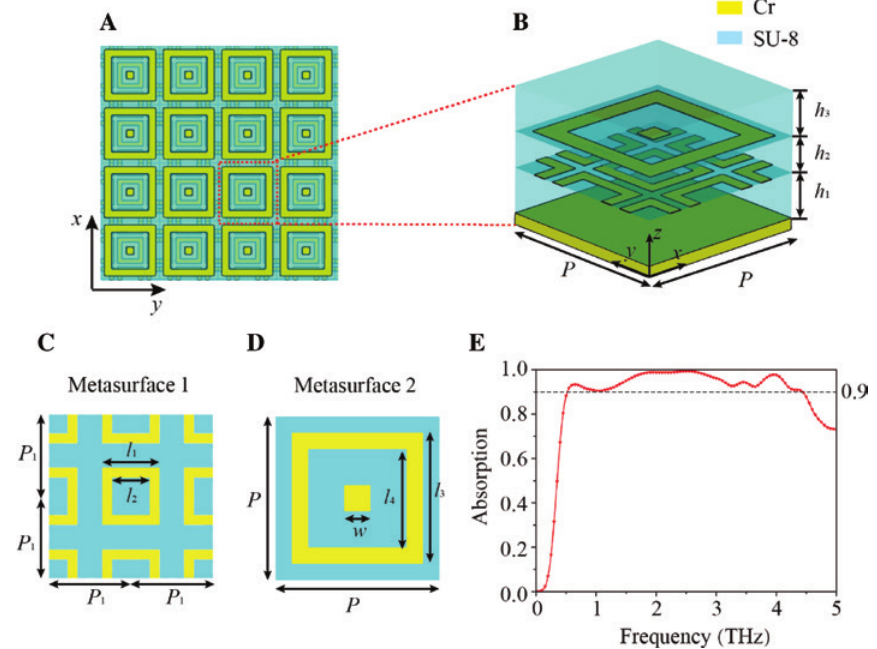
Figure 1: Schematic structure of the broadband THz absorber and simulated results. (A) Top view of the arrays. (B) Three-dimensional schematic diagram. Top views of (C) metasurface 1 and (D) metasurface 2 with geometric parameters. (E) Simulated absorption spectra at normal incidence in the frequency range from 0 to 5